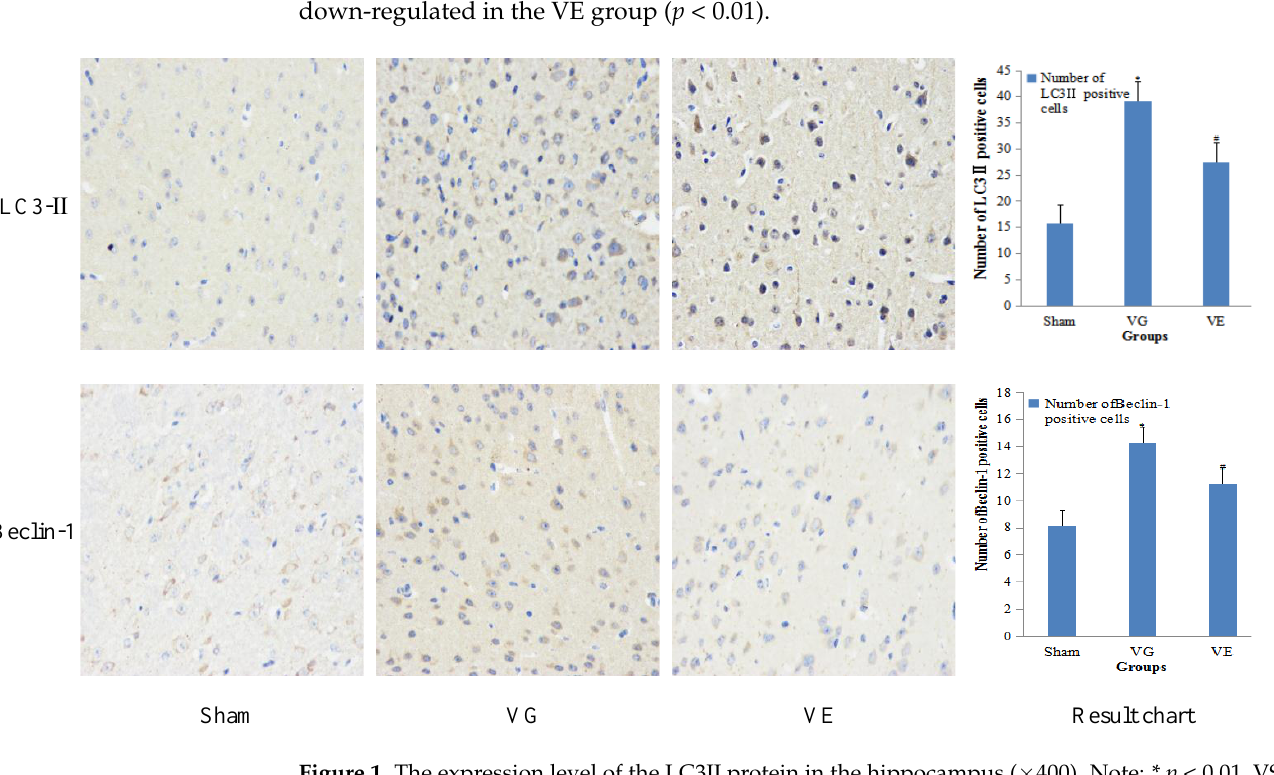
Figure 1. The expression level of the LC3 Ⅱ protein in the hippocampus.(×400). Note ： * p < 0.01, VS Sham, # p < 0.05, VS VG. Table 4. The RT-PCR detection results of the hippocampus of vascular dementia rats with aerobic exercise intervention ( n =